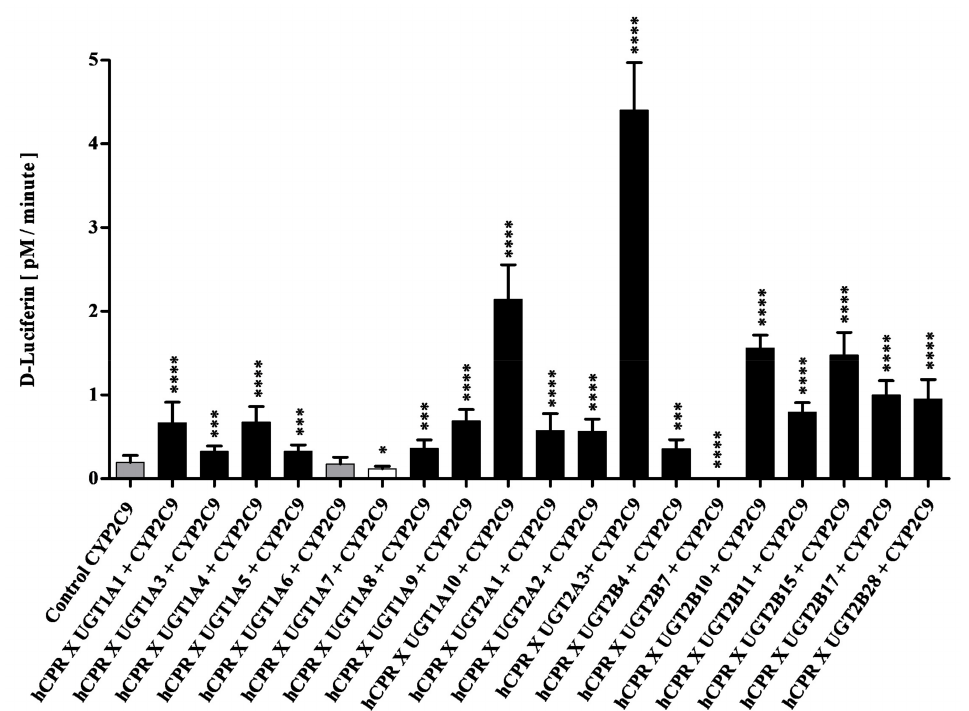
Figure 2. Enzymatic activities of enzyme bags prepared from diploid strains co-expressing CYP2C9, CPR, and different UGTs as indicated. Activities towards the substrate Luciferin-H are shown in comparison to the control strain SAN200 (which co-expresses CYP2C9 and CPR without a UGT). Activities that are not different from the control are shown in grey, while those that are statistically significantly higher or lower than the control are shown in black or white, respectively. * p < 0.05, *** p < 0.005, **** p <